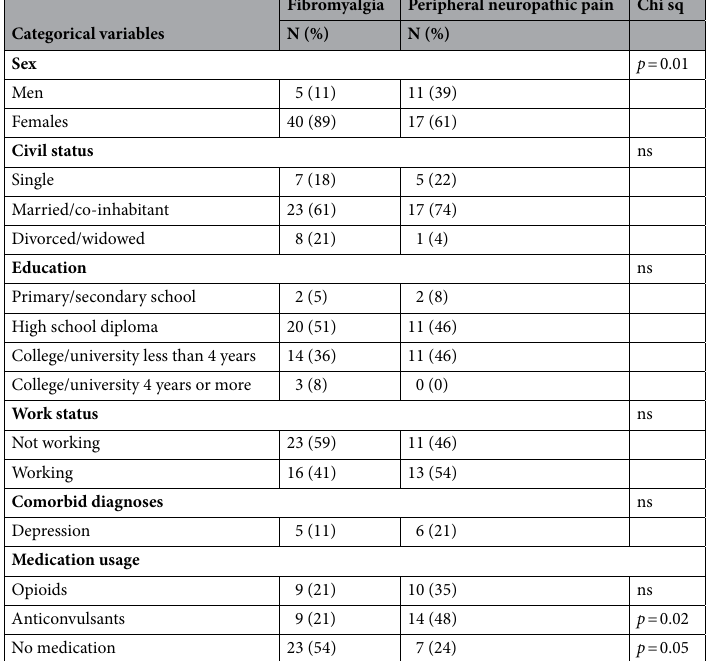
Table 3. Demographics, patient reported outcomes and medication usage a are presented in 73 patients with either Fibromyalgia or Peripheral neuropathic pain (included from 2016–2018). Variables are categorical, cross tabulated and tested with a Chi Square significance test between the two different pain conditions. a N does not equal PNP = 28 or FM = 43 on all variables due to missing data, or participants responding with “not